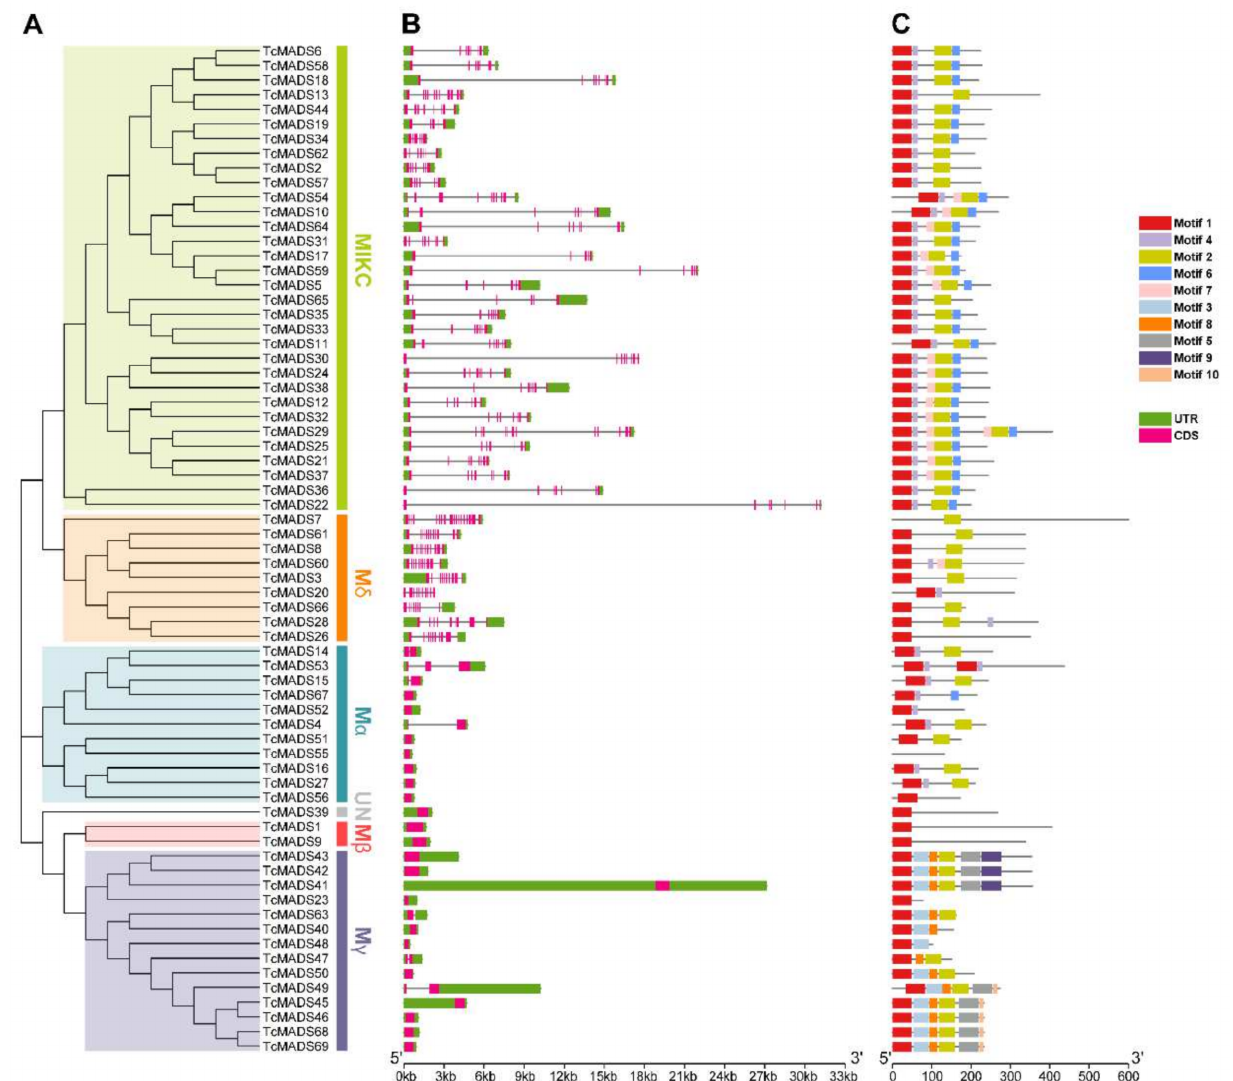
Figure 2. Phylogenetic relationship, gene structure and conserved motifs of the TcMADS genes. ( A ) An unrooted NJ tree (left side of the figure) obtained using the MEGA X based on coco tree MADS-box protein sequences. ( B ) The exon–intro structures of Theobroma cacao MADS-box genes (central of the figure) were displayed by TBtools software. ( C ) Conserved motif composition of the TcMADS proteins (right side). Detailed information on the ten motifs is provided in Supplementary Table